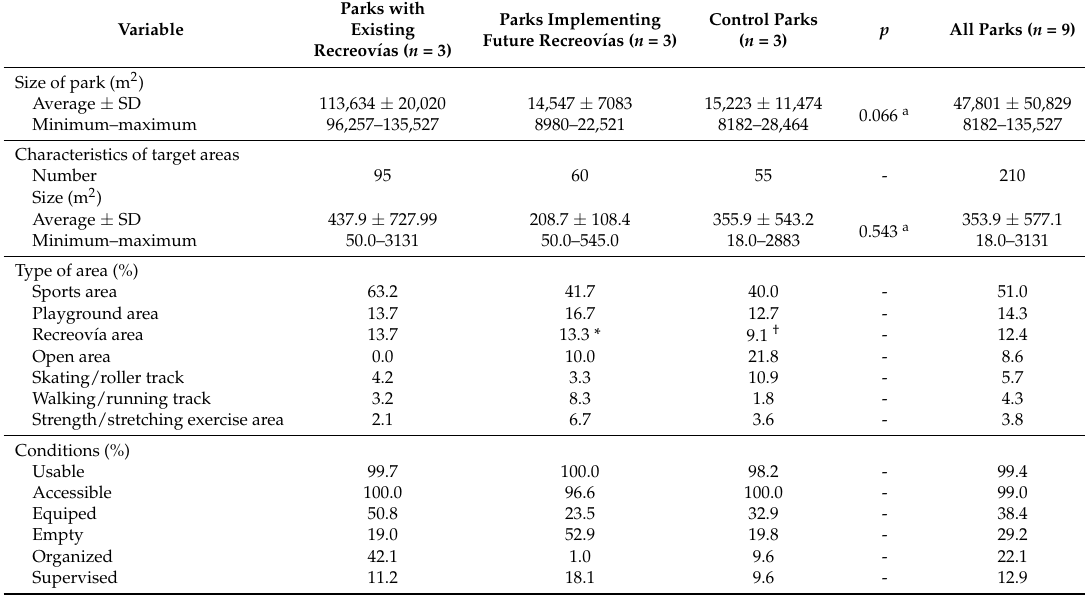
Control Parks p All Parks ( n = 9) ( n = 3)